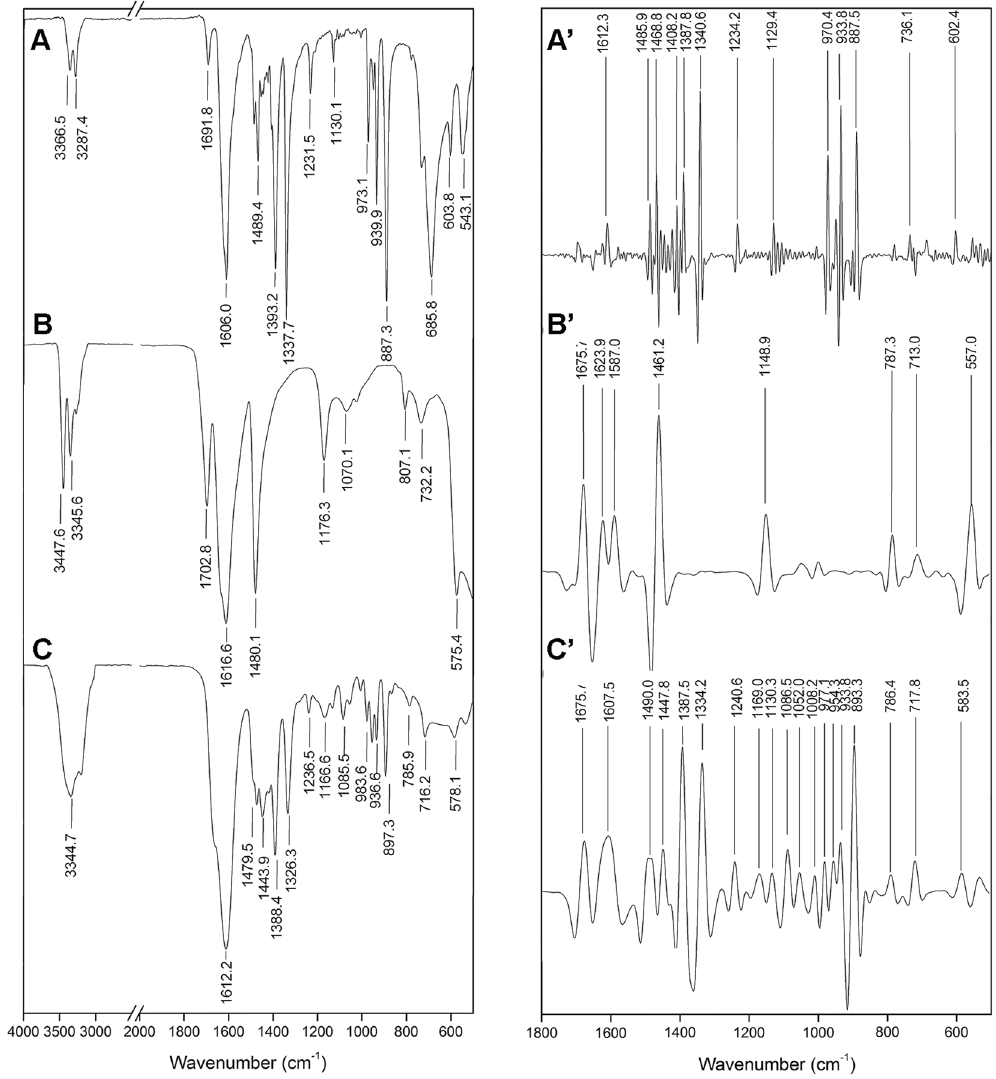
Figure 2. Vibrational characterization of betaine ( A ) urea ( B ) and BU ( C ) through FT-IR spectroscopy and second derivative spectrums, respectively (A’, B’ and